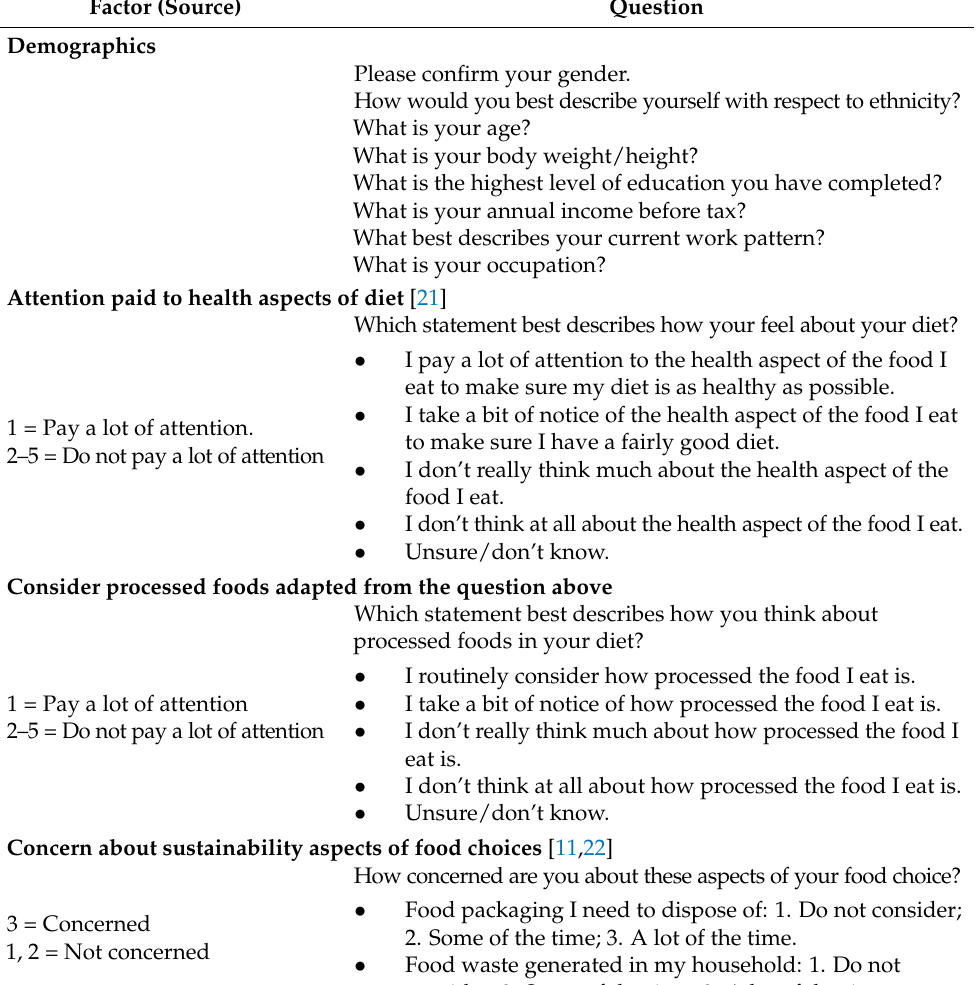
Table 1. Healthy Eating Message Design (HEMD) Survey questions measuring attention paid to health aspects, the level of food processing of a participant’s diet, and concern about food waste and disposal of food